Question: What caption would you write for this figure?
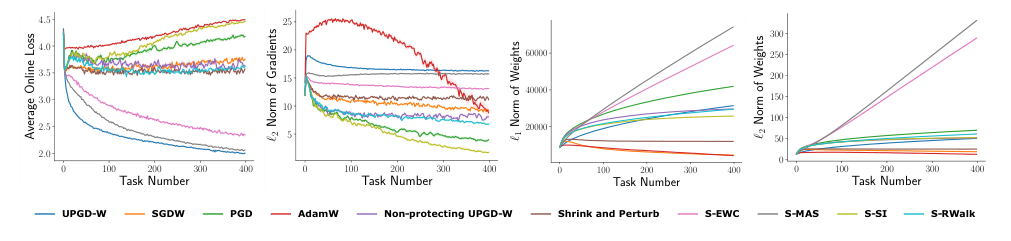
Answer: Diagnostic Statistics of methods on Label-permuted mini-ImageNet. The average plas- ticity, percentage of zero activations, ℓ0, ℓ1 and ℓ2-norm of gradients, the average online loss, the ℓ1-norm and ℓ2-norm of the weights are shown. The shaded area represents the standard error.